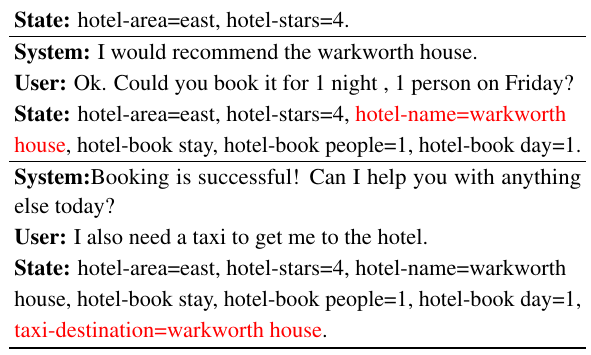
Table 1 Example of multi-domain dialogs. The